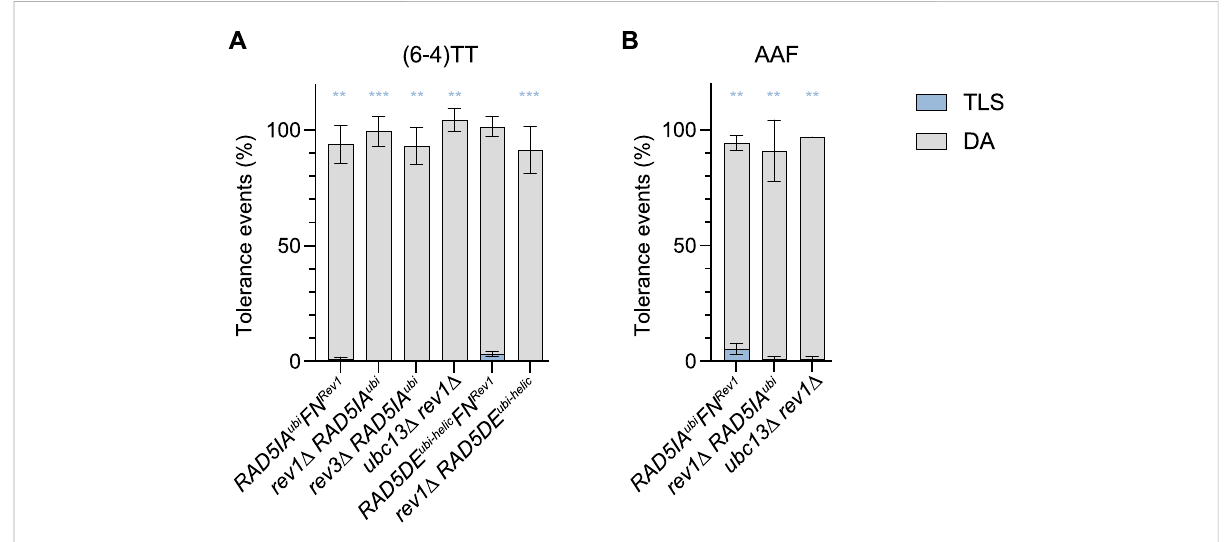
FIGURE 3 Role of Rev1 and Rad5-Rev1 interaction in the partitioning of DDT pathways through (6 — 4)TT (A) and N2dG-AAF (B) lesions. Tolerance events represent the percentage of cells able to survive in presence of the integrated lesion compared to the lesion-free control. The data represent the average and standard deviation of at least three independent experiments. Unpaired t -test was performed to compare TLS values from the different mutants to the parental strain (* p < 0.05; ** p < 0.005; *** p < 0.0005).